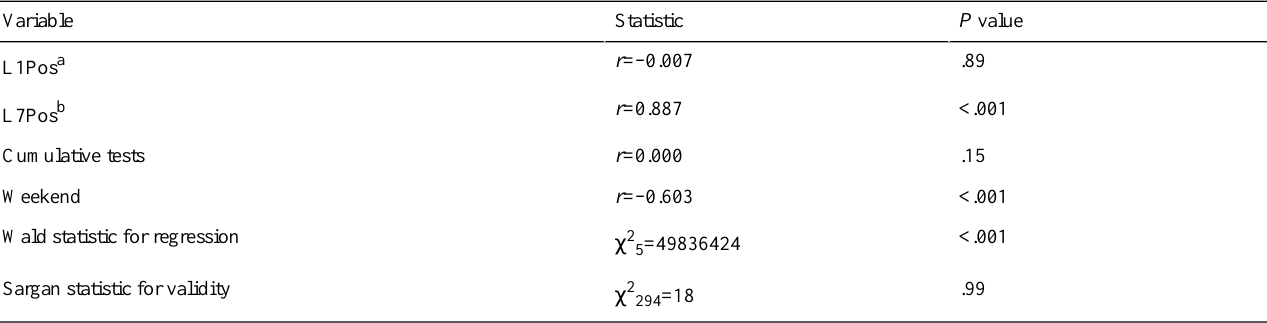
Regression results are presented for 26 East Asian and Pacific countries in Table 1. Weekly surveillance data in Tables 2-6 Table 1. Arellano-Bond dynamic panel data modeling of the number of daily infections reported by country in East Asia and the Pacific, October 5-18, 2020.